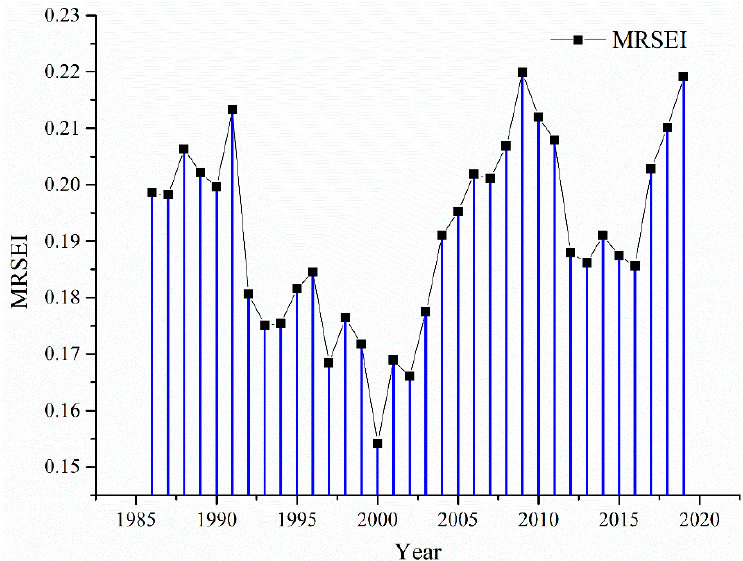
Figure 7. Annual mean value of the MRSEI in the Qaidam Basin from 1986 to